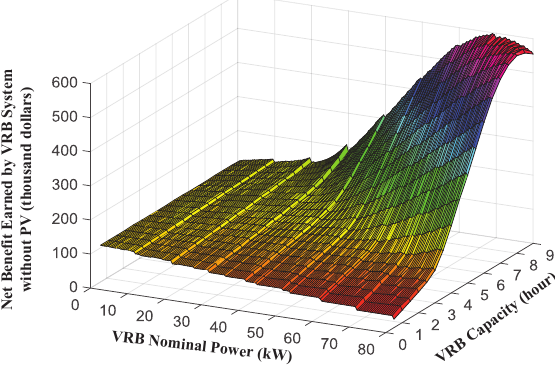
Figure 12. Net economic benefit earned by the VRB system without PV (in thousand dollars).